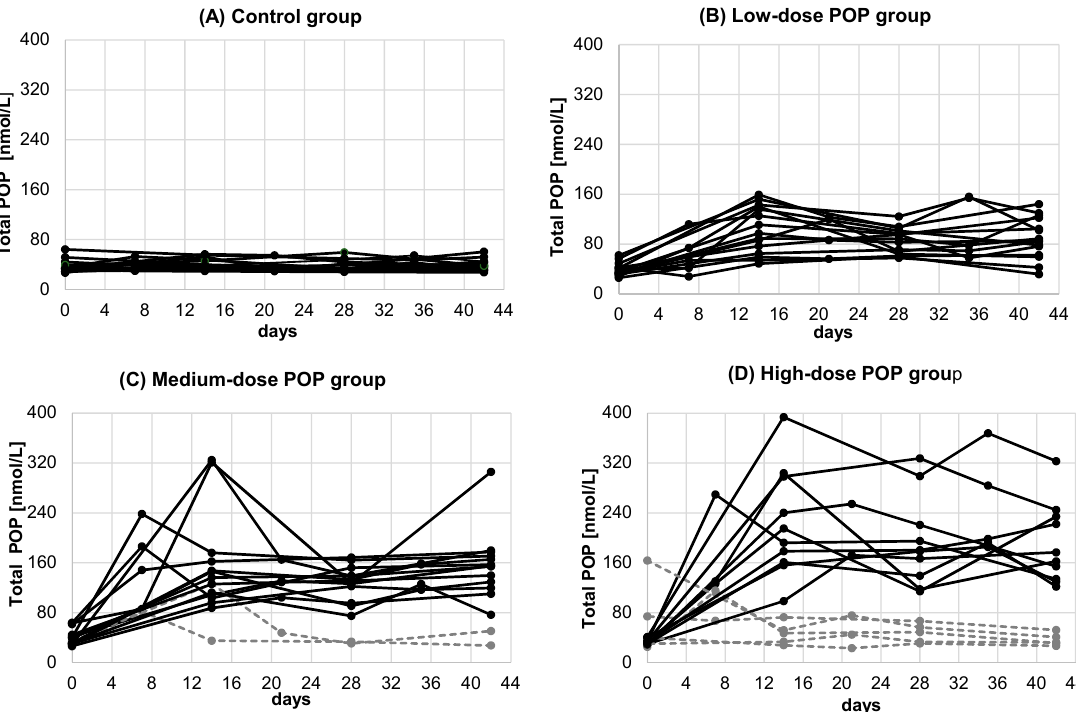
Figure 2. Individual serum POP concentrations over the six ‐ week intervention period in study participants consuming increasing doses of POP (PP1 study population). (A) control group, (B) low ‐ dose POP group, (C) medium ‐ dose POP group, (D) high ‐ dose POP group. The seven individuals in the medium dose (C) and high ‐ dose (D) POP groups who were excluded from the PP1 study population (for details, see under 3.1) are marked in grey with dashed lines. Total POP refers to the sum of all individual POP measured including 7 ‐ keto and 7 α‐ and 7 β‐ OH ‐ derivates of PS.